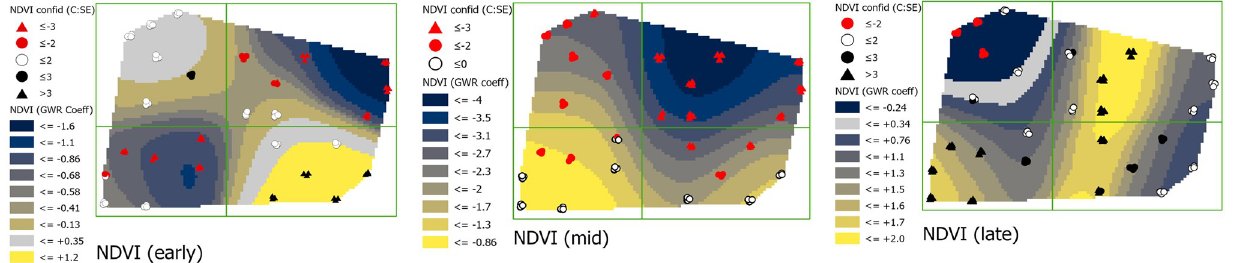
Fig 9. Maps showing early, mid-, and late season NDVI coefficients with estimations of credence in coefficient values. Coefficient surface values were symbolized using a geometric interval classification scheme from blue to gold, with grey indicating the interval including zero (if present).